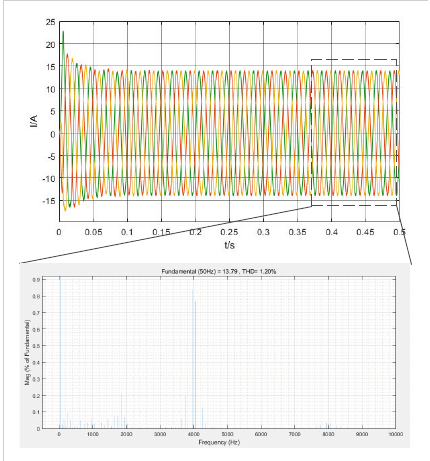
Figure 19. The amount of THD in line voltage coordinate when m = 0.6, D =